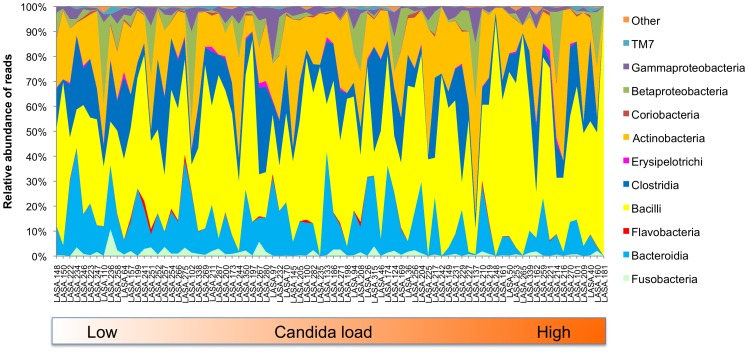
Relative abundance of bacterial taxa in saliva samples at the class level.The sample order corresponds to the increase in Candida load in the samples (Table S2). The Candida load was measured as proportion of ITS gene over 16S gene abundance by qPCR. Increase in Candida load correlated positively with reads classified as Bacilli (p = 0.013; Spearman’s rho 0.274), while class Bacteroidia (p = 0.001; Spearman’s rho −0.360), Flavobacteria (p = 0.003; Spearman’s rho −0.322), Fusobacteria (p = 0.012; Spearman’s rho −0.275) correlated negatively with the Candida load (Figure S1).